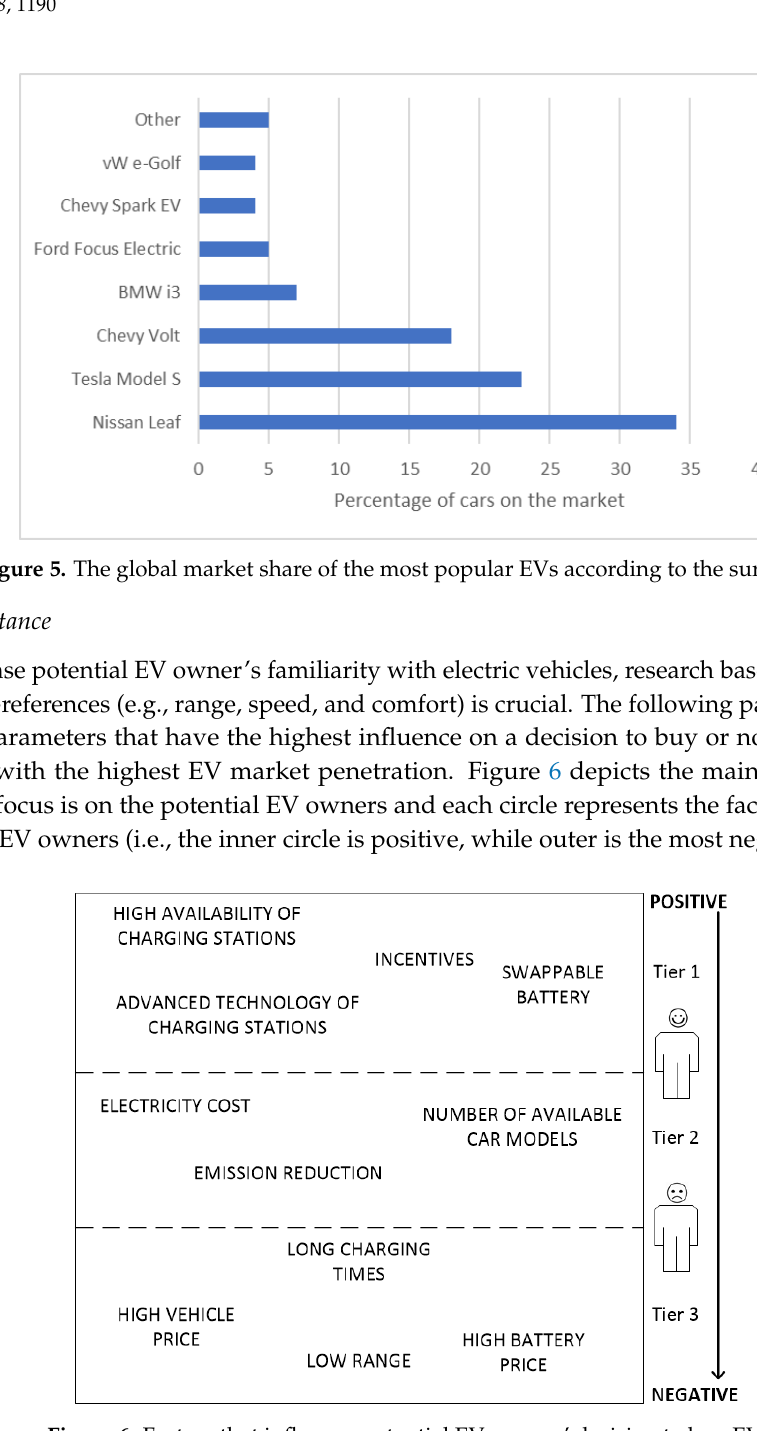
Figure 6. Factors that influence potential EV owners’ decision to buy